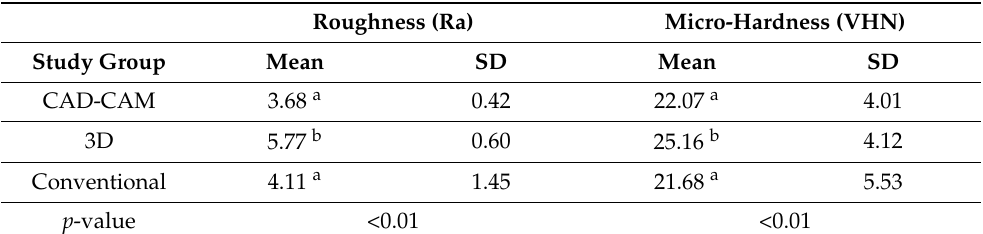
presents surface roughness micrographs for different samples in CC (Figure 2A), 3D (Fig- ure 2B), and CV (Figure 2C) samples.